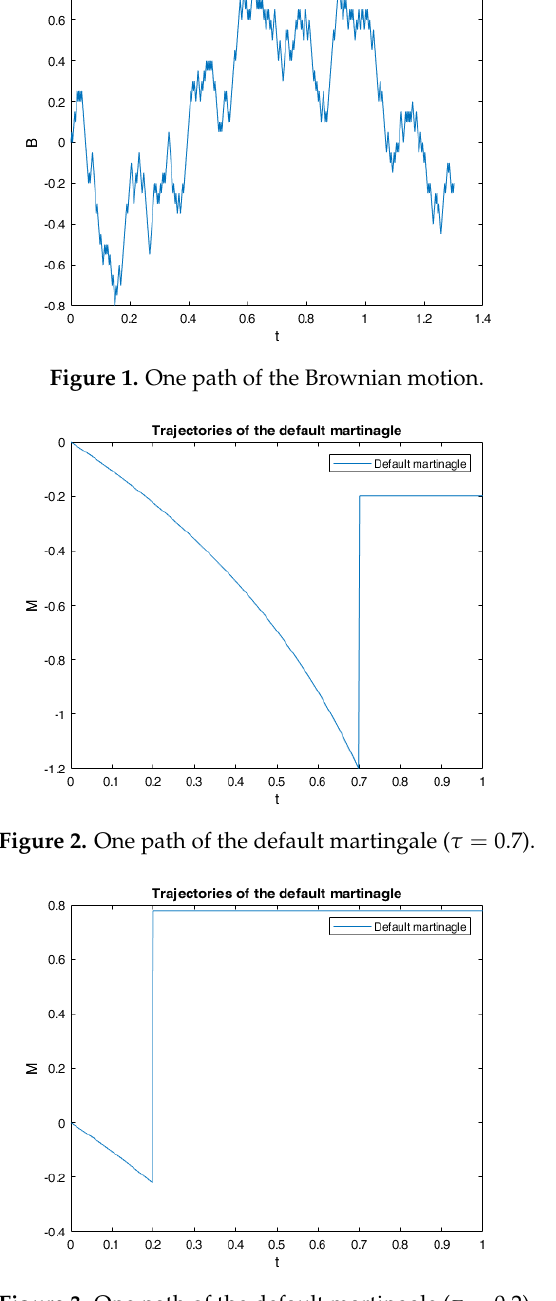
Figure 3. One path of the default martingale ( τ =